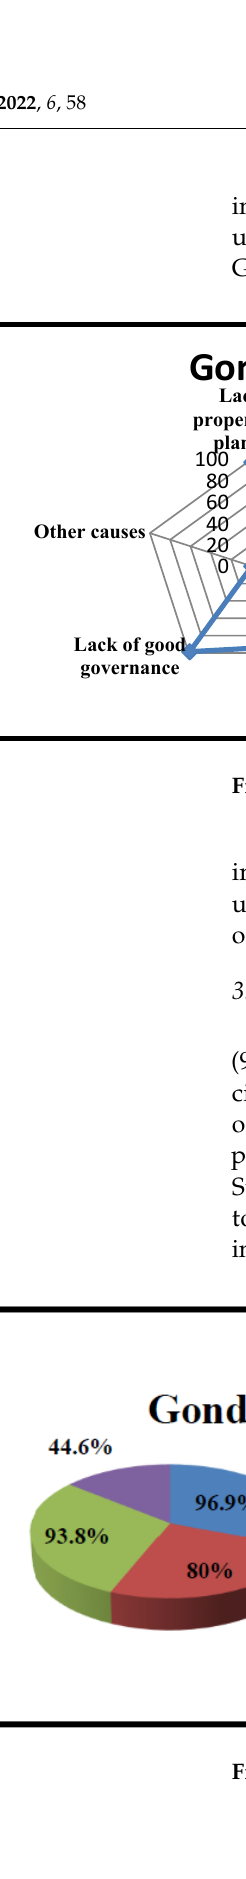
Figure 2. Understanding level of the concept of urban resilience. Source: Field survey, 2021